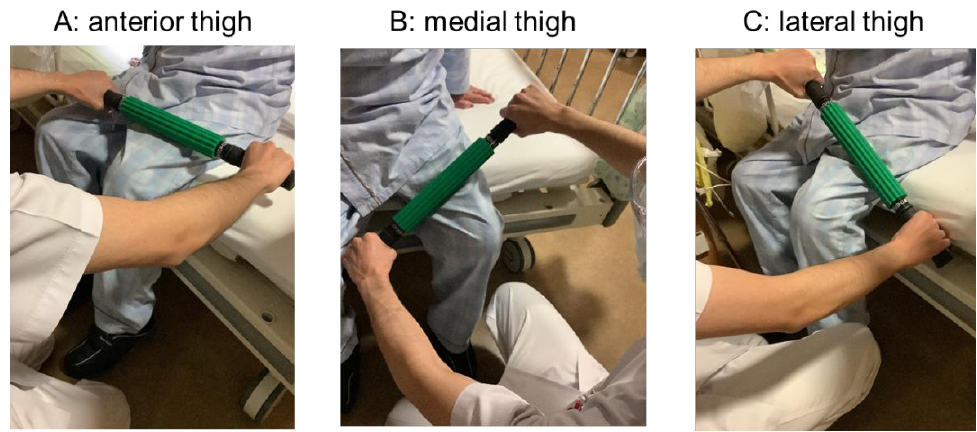
Figure 2. Foam rolling intervention for anterior thigh ( A ), medial thigh ( B ), and lateral thigh ( C ).